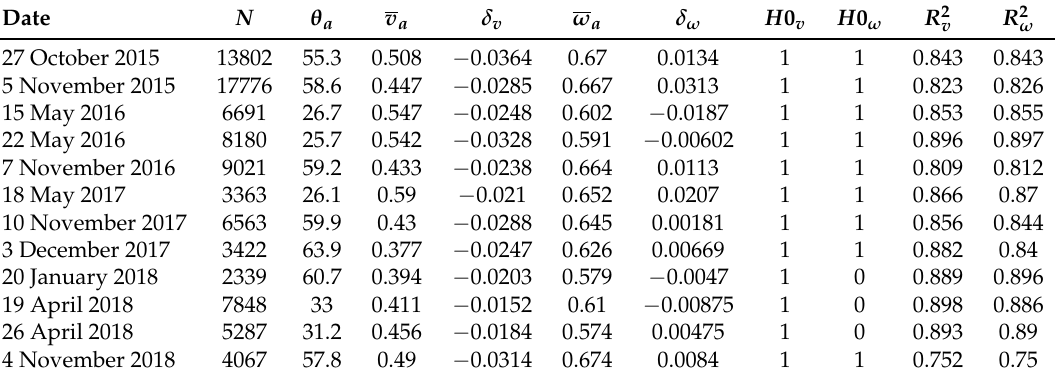
Table 6. Summary of the statistical analyses showing agreement between the AHI and MODIS NDVIs as well as between the AHI and MODIS NDVI-based indices over the Tohoku region. N is the number of pixels sampled on each date. θ a is the AHI solar zenith angle averaged over the area for each